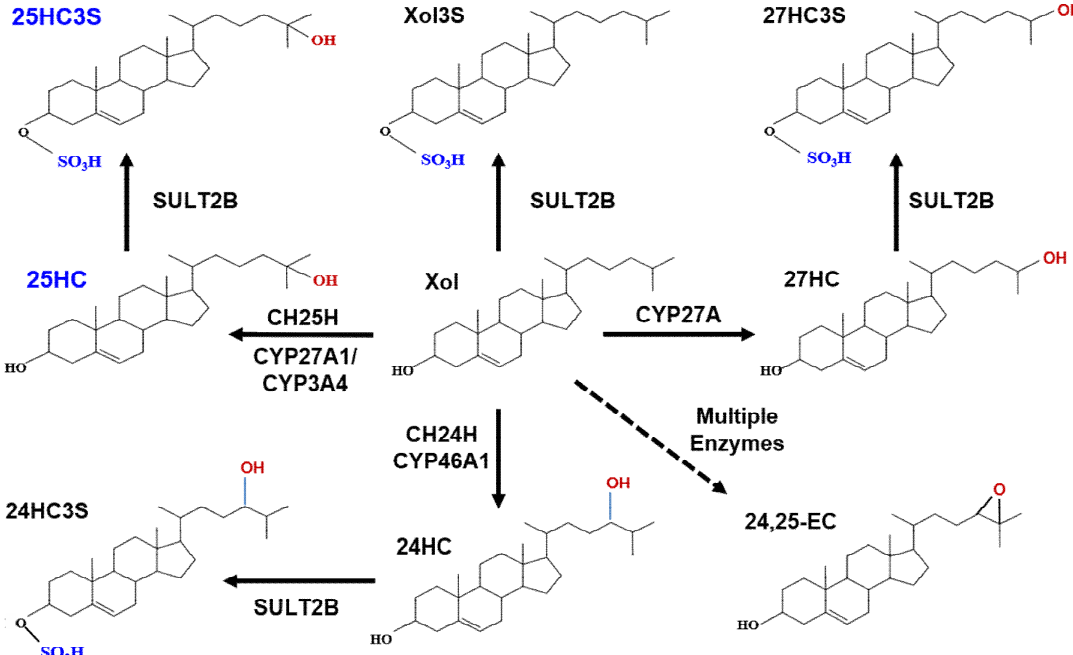
Figure 1. Metabolic pathway of oxysterol sulfates.